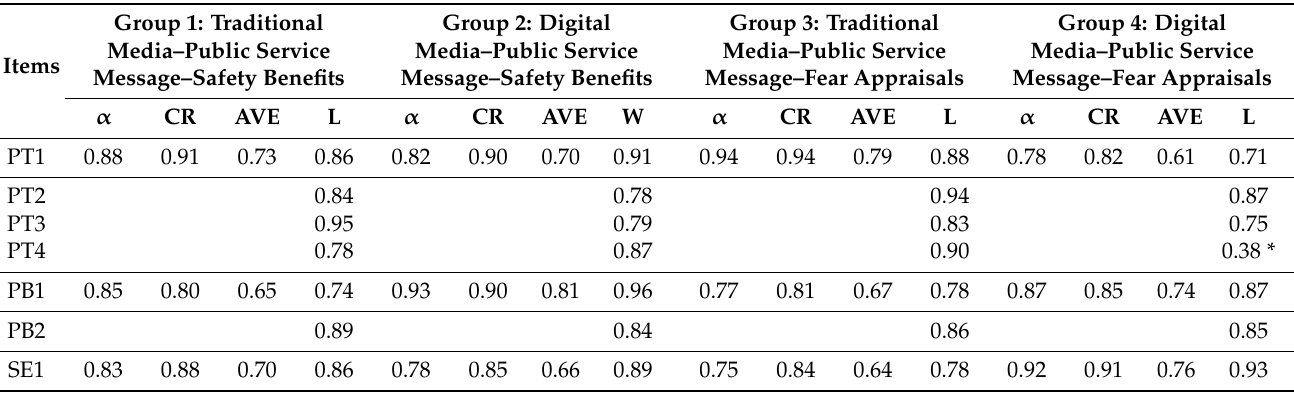
Table 4. Validity Statistics and Standardized